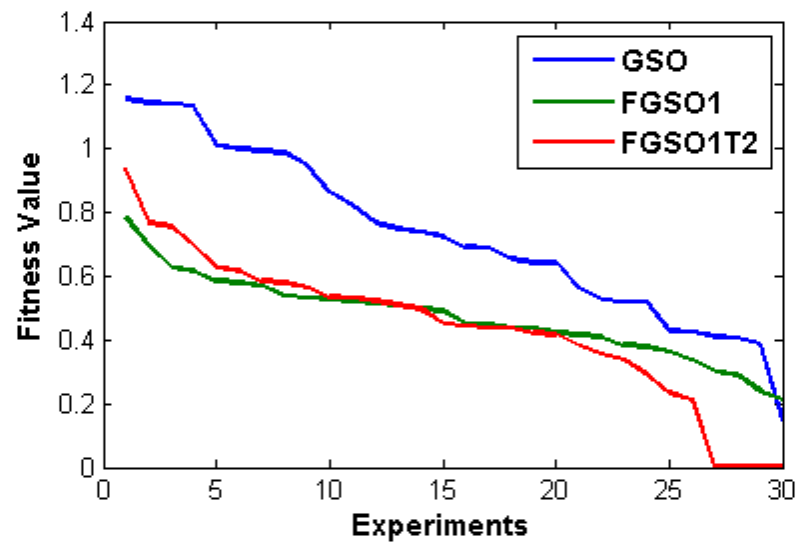
Figure 14. Results for GSO, FGSO1 and FGSO1T2 with noise.